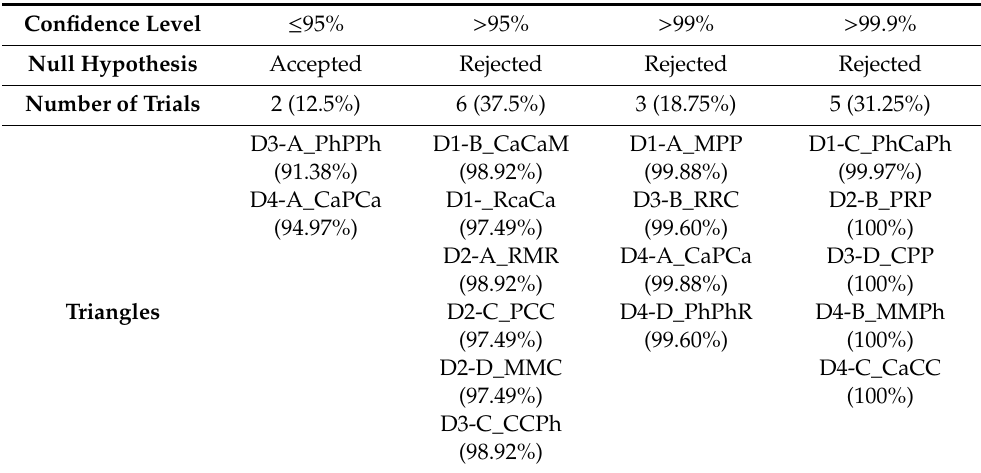
Table 7. Results of the triangular sensory analysis for a significance level of α = 0.5 and p -value for each